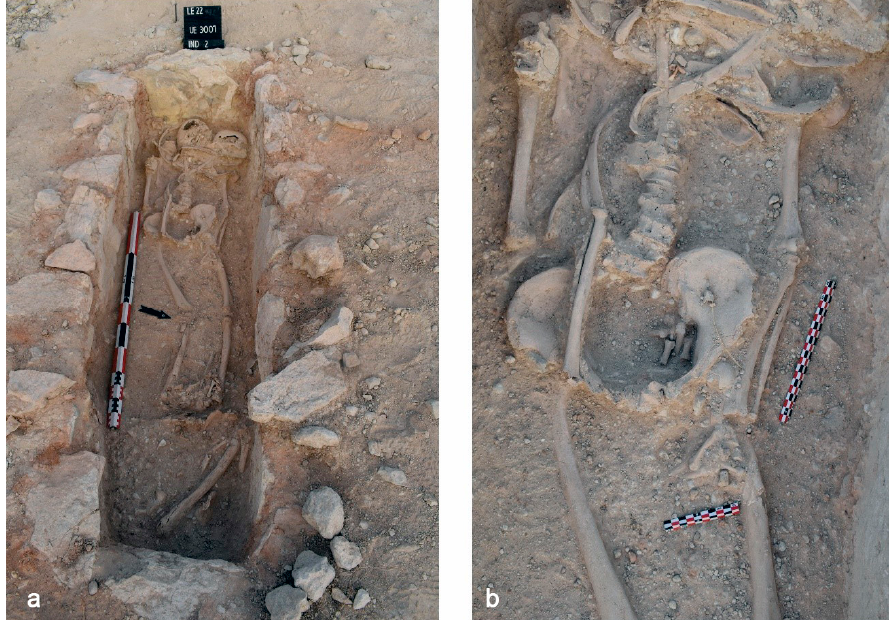
Figure 7. ( a ) The tomb excavated in 2022 in which three individuals were buried with a stone cist orientated from west to east. ( b ) Details of the pregnant woman and the remains of the